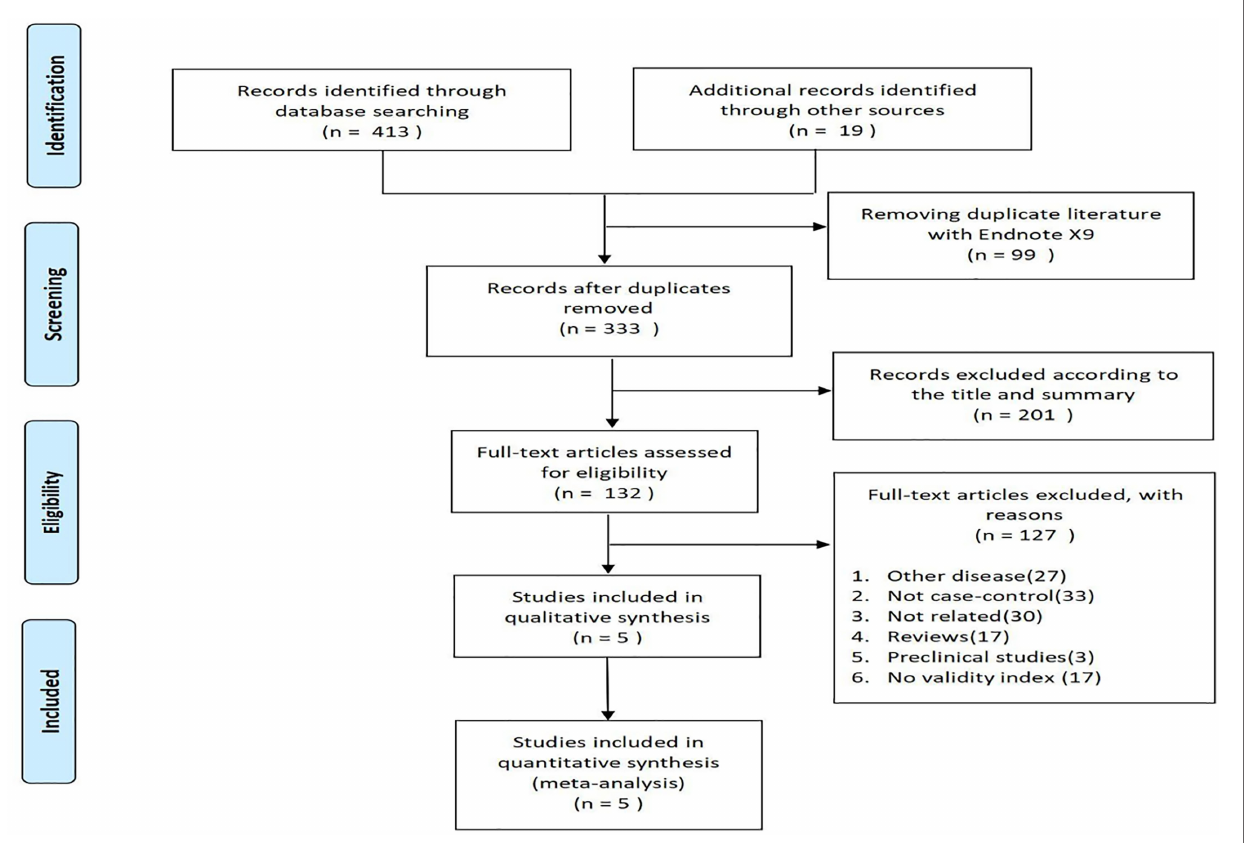
FIGURE 1 | Flowchart of studies evaluating quali fi ed research through selection